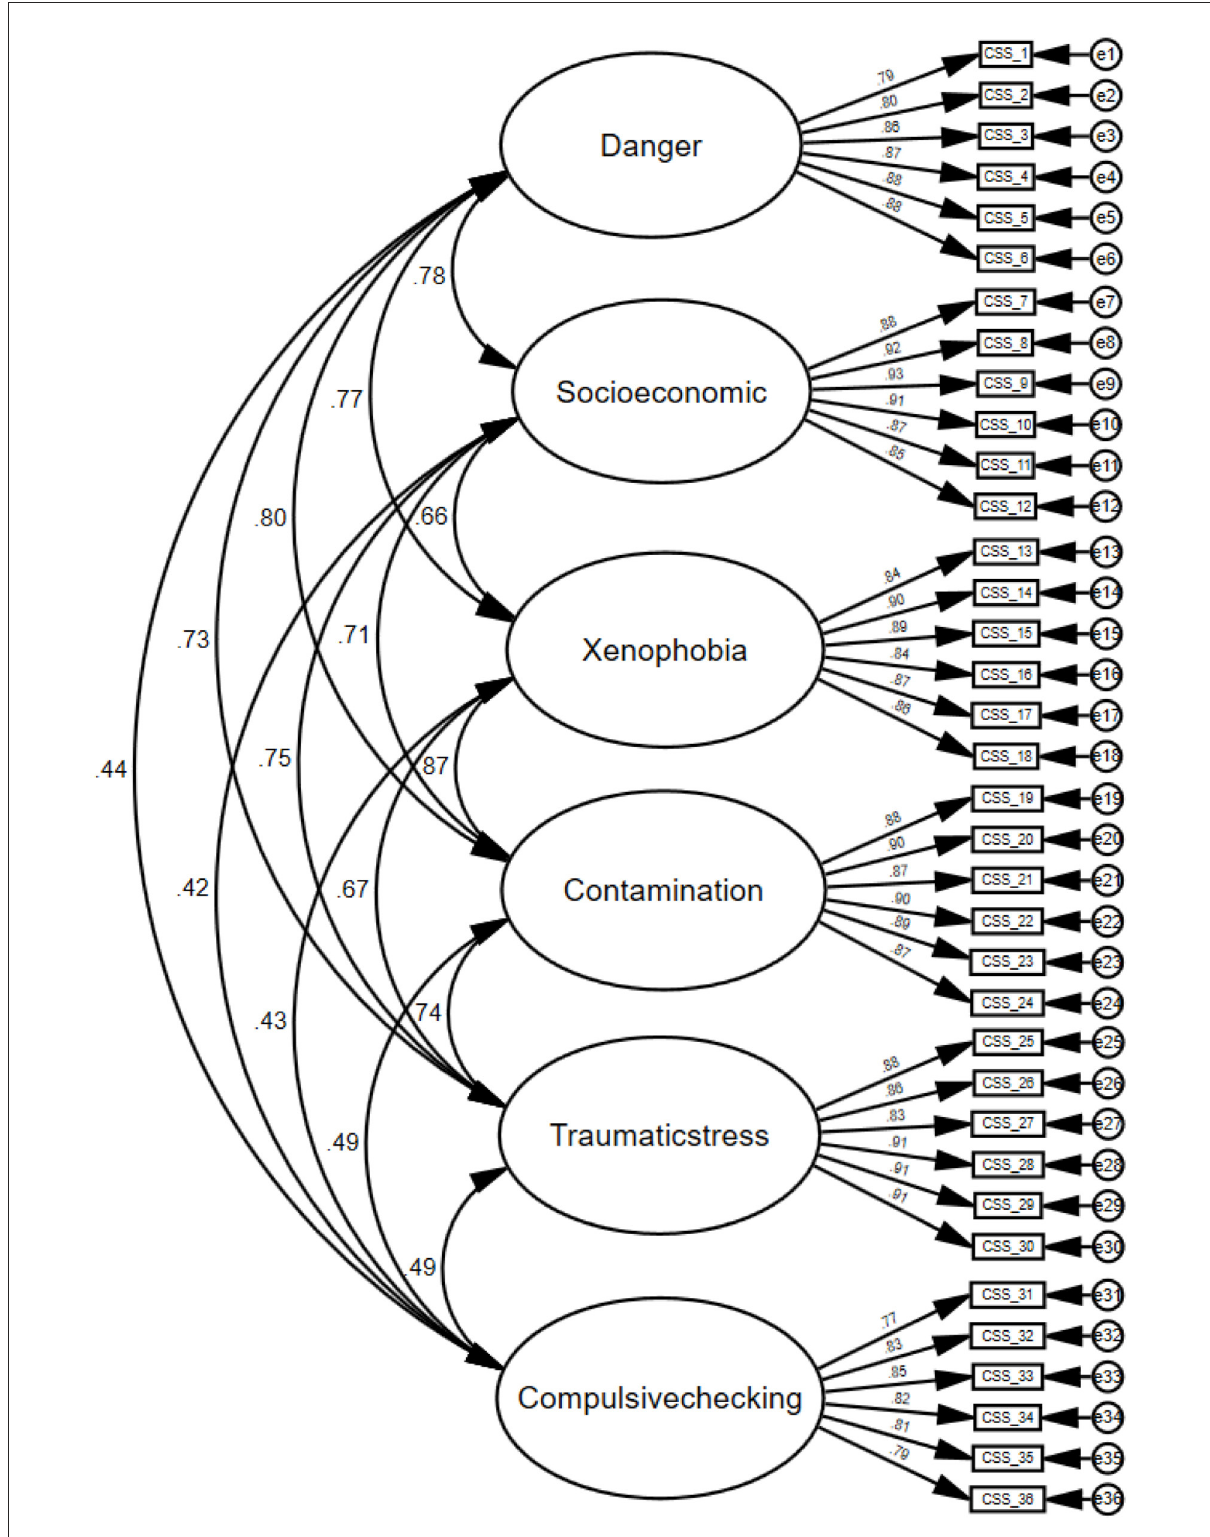
FIGURE1 Confirmatory factor analysis of the COVID Stress